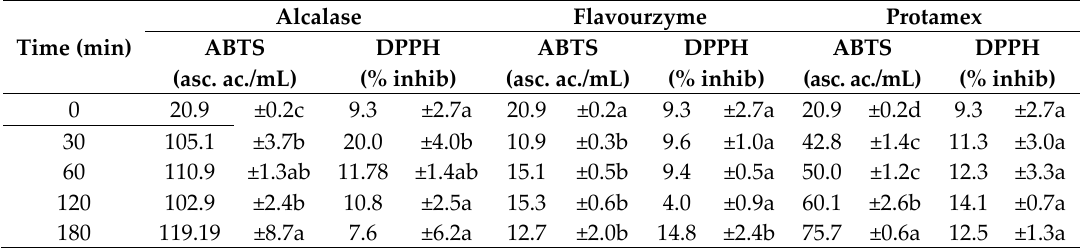
ABTS expressed as ascorbic acid µg equivalents/mL of hydrolyzate; DPPH expressed as percentage of inhibition of 0.1 mL of hydrolyzate. Values followed by the same letter within each column are not significantly different, p >